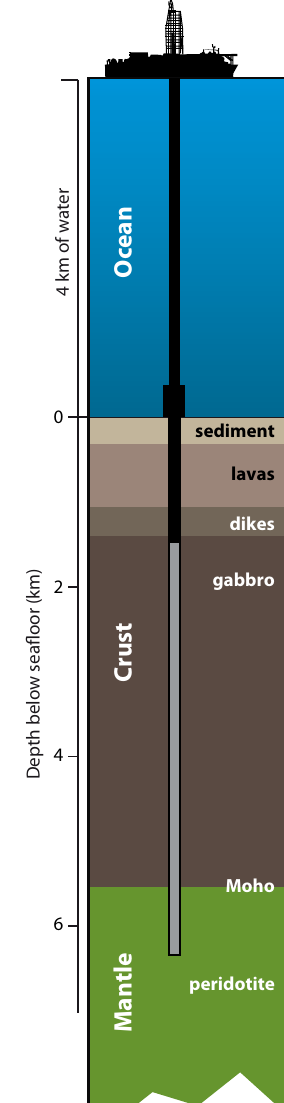
figure 4.3. cartoon showing known and inferred stratigra- phy around odp/iodp hole 1256d in the eastern equato- rial pacific ocean, on the east flank of the fast-spreading east pacific rise. depth of penetration thus far by scientific ocean drilling is shown in black; section of hole shown in gray indicates additional penetration that would be required to achieve a complete penetration of the oceanic crust and uppermost mantle. note that the drillship would be about 100 times smaller if it were drawn to